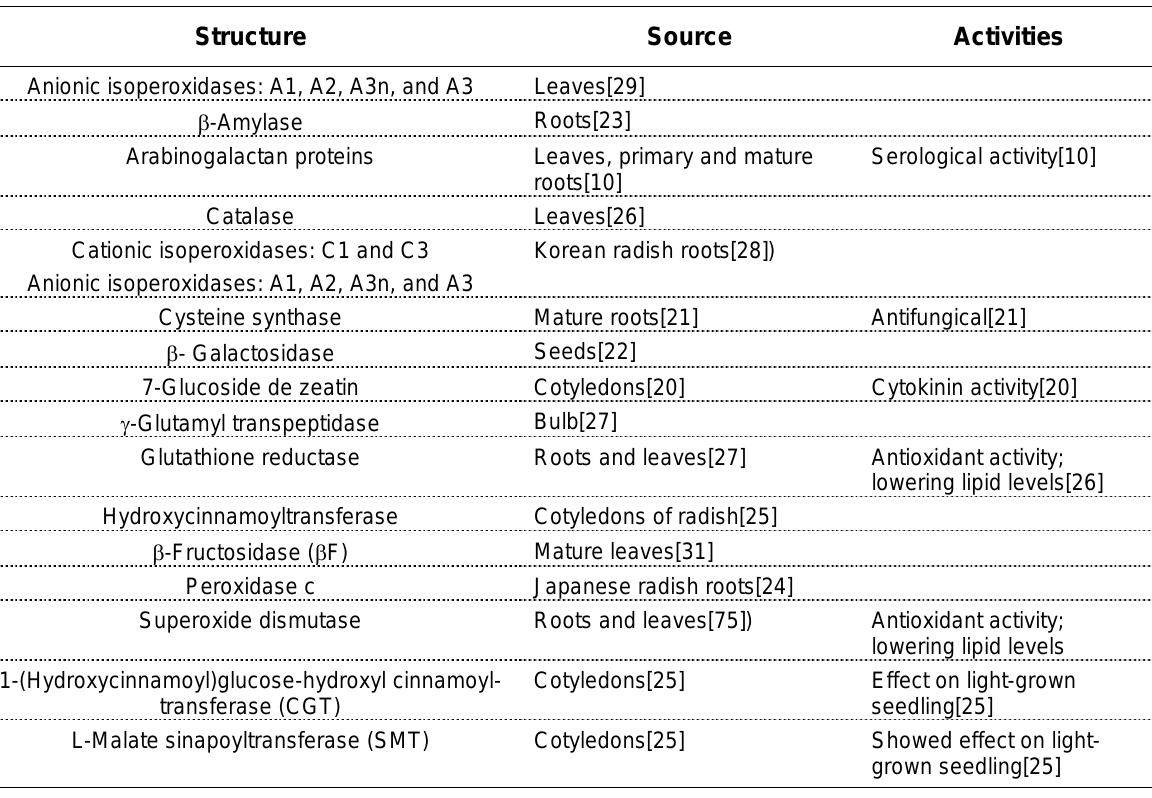
Enzymes Isolated from Radish